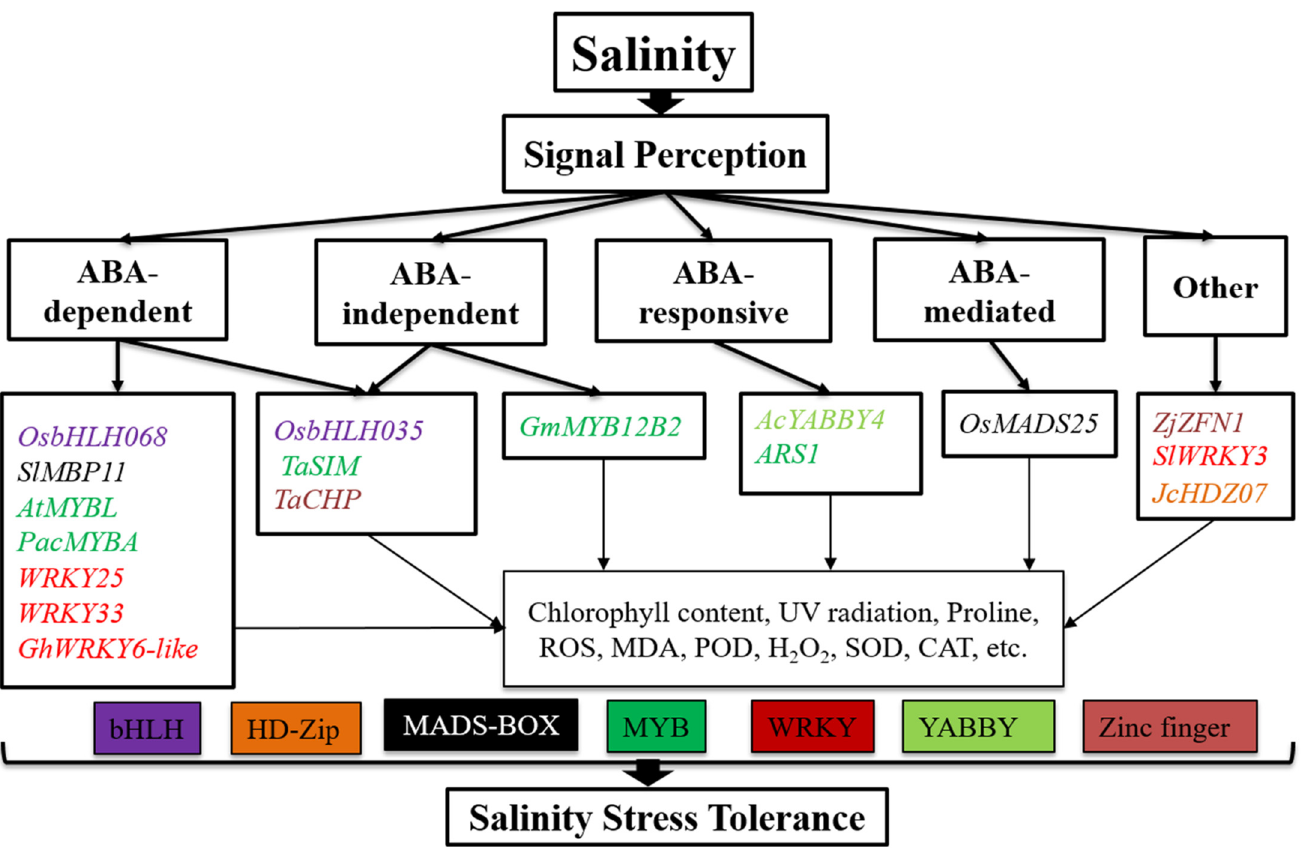
Figure 3. Genes and signaling pathways that regulate salinity stress tolerance. These pathways include the bHLH, HD-Zip, MADS-box, MYB, WRKY, YABBY, and zinc finger. These regulators control salinity stress tolerance through ABA-independent, -responsive, and -mediated pathways, among others, playing an essential role in ROS, chlorophyll content, MDA, POD, SOD, CAT, UV radiation, and proline content. Different text colors represent different transcription factors.